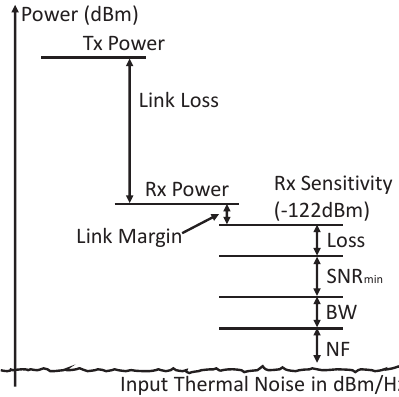
Figure 5. The link budget analysis of the